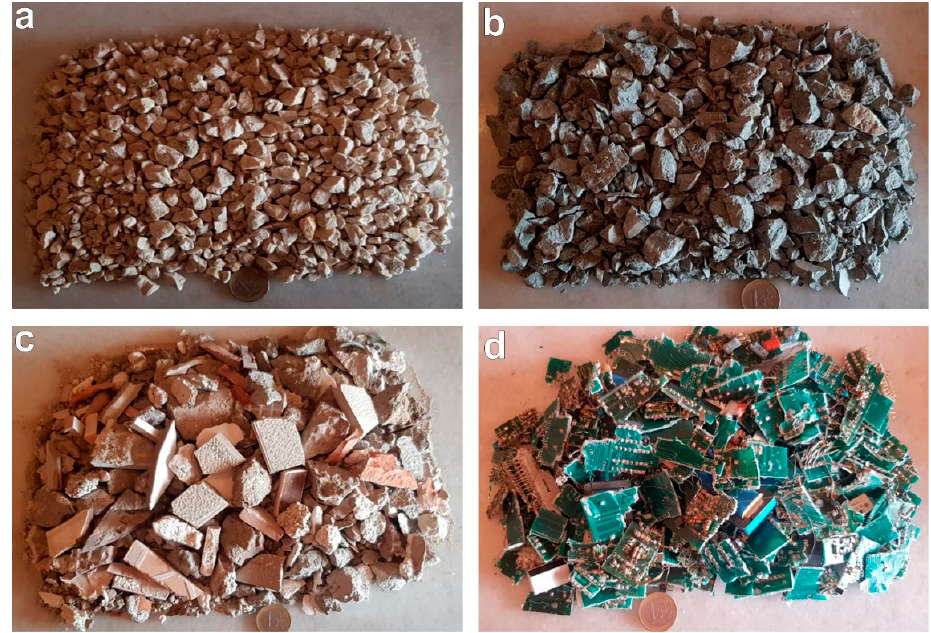
Figure 1. Representative photos of aggregate components showing: ( a ) limestone; ( b ) basalt; ( c ) hotel construction wastes; ( d ) e ‐ wastes.